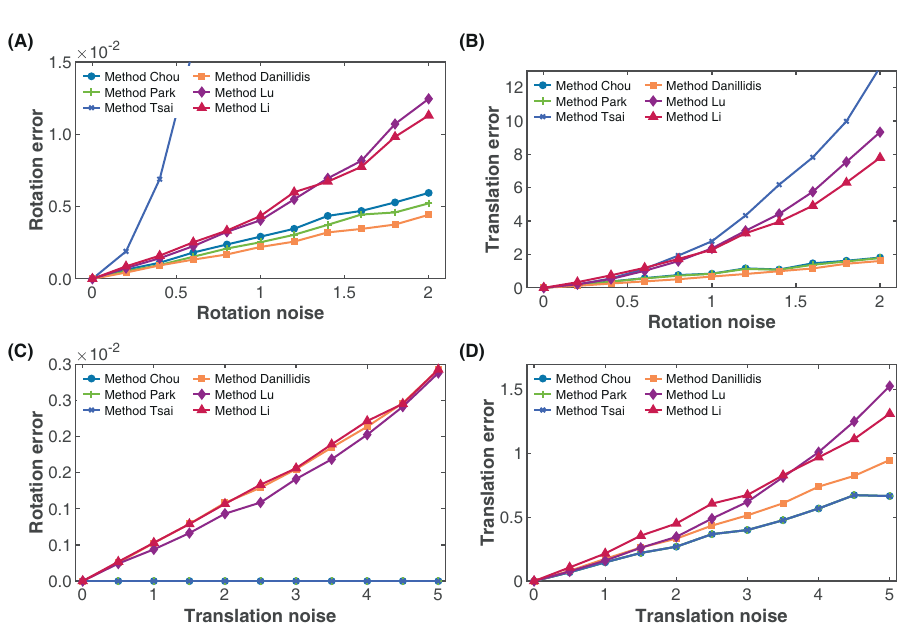
Fig 5. Effect of rotation and translation noise on rotation and translation calibration accuracy. (A) Effect of rotation noise on rotation accuracy. (B) Effect of rotation noise on translation accuracy. (C) Effect of translation noise on rotation accuracy. (D) Effect of translation noise on translation